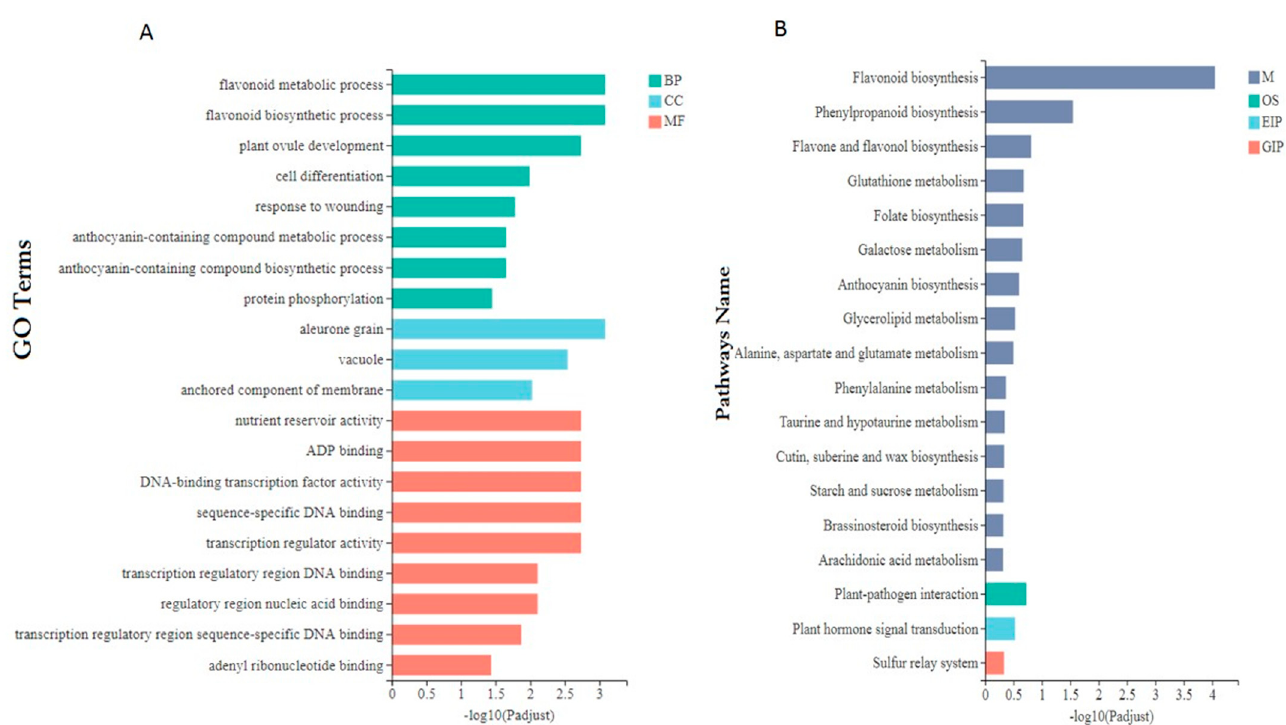
Figure 7. GO and KEGG enrichment: ( A ) Bar diagram showing GO enrichment in Bc vs. Wc; MF indicates the category molecular function; CC, the category cellular component; BP, the category biological process. ( B ) Histogram showing KEGG enrichment in Bc vs. Wc; the ordinate represents the KEGG pathway and the abscissa represents the significance level of enrichment under p -adjust < 0.5, which corresponds to the height of the column. The smaller the FDR and the greater the − log10 (FDR) value, the more significantly enriched the KEGG pathway. Different colors indicate 4 enriched branches of the KEGG metabolic pathway: genetic information processing (GIP), environmental information processing (EIP), biological systems (OS), and metabolism (M).